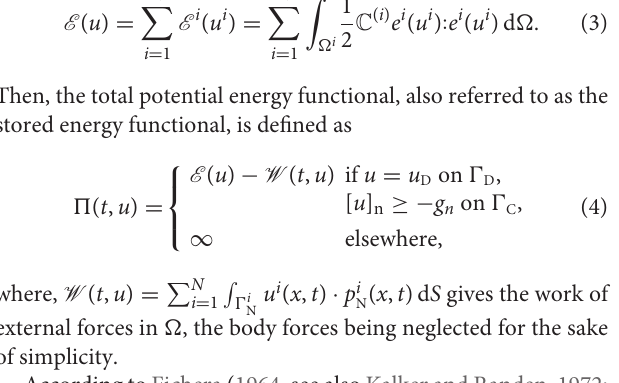
to as opening, decreases when subdomains (cid:127) i and (cid:127) j are getting closer, and [ u ] n + g n ≥ 0 should hold. [ u ] t is referred to as sliding. + [ u ] t τ i Therefore, [ u ] ij = [ u ] n ν i . In fact, the model does not j j depend on the chosen orientation, and indices i and j are omitted when displacement jump is defined on Ŵ . The relations between C the components of the tractions and displacement jump on a unilateral contact surface are shown in Figure 2 , which indicates that σ n ≤ 0 if [ u ] n + g n = 0 (contact), no overlapping being allowed, whereas σ n = 0 if [ u ] n + g n > 0 (separation), and σ t = 0 in both